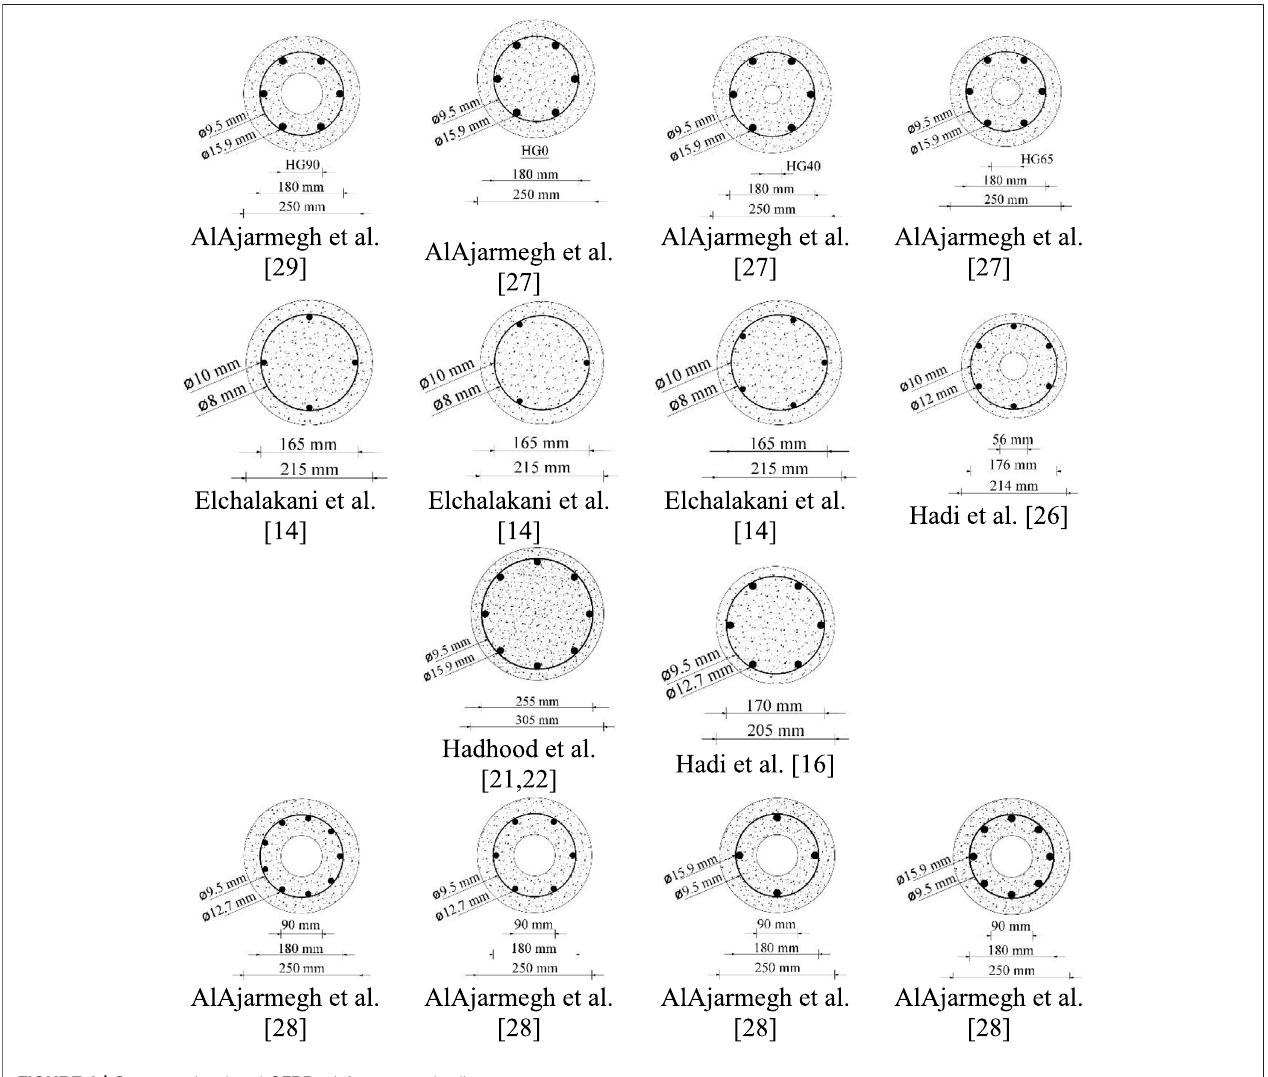
FIGURE 2 | Cross-sectional and GFRP reinforcement